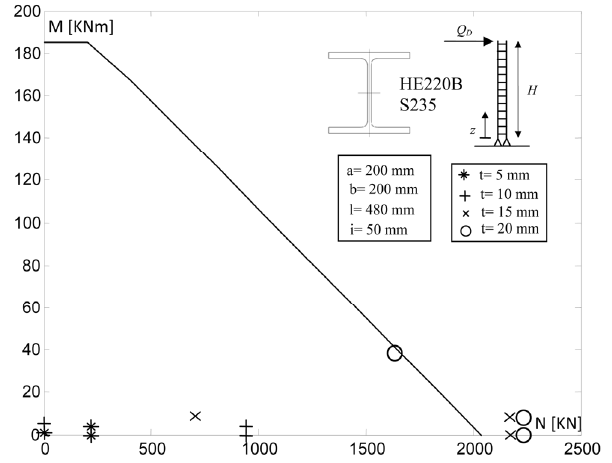
Figure 7. Model A_2: Stress Points on MN Domain at last pushover step.